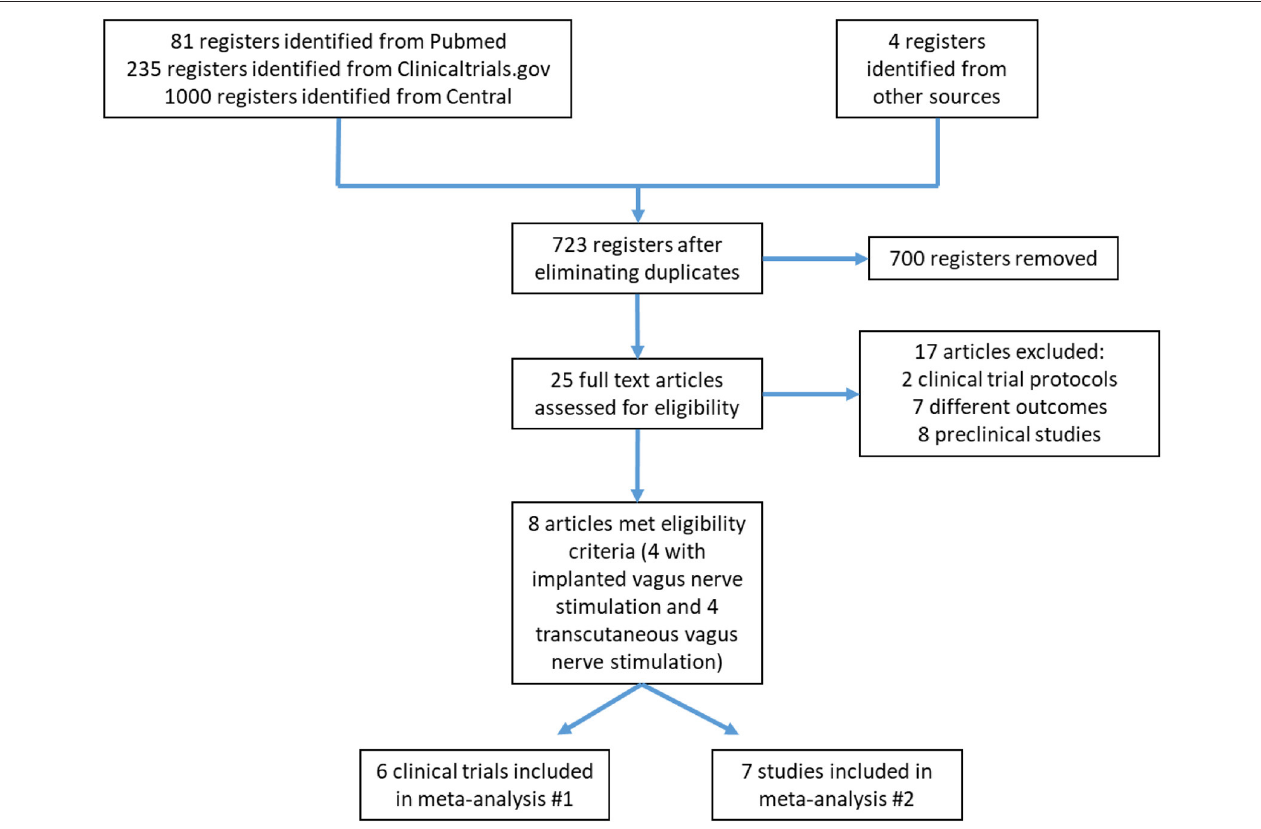
FIGURE 1 | Flow diagram of study searching and selection